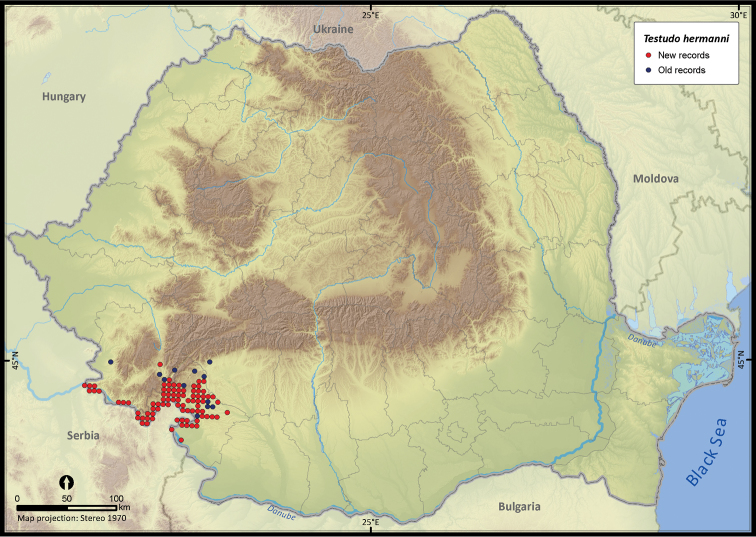
Testudo hermanni.